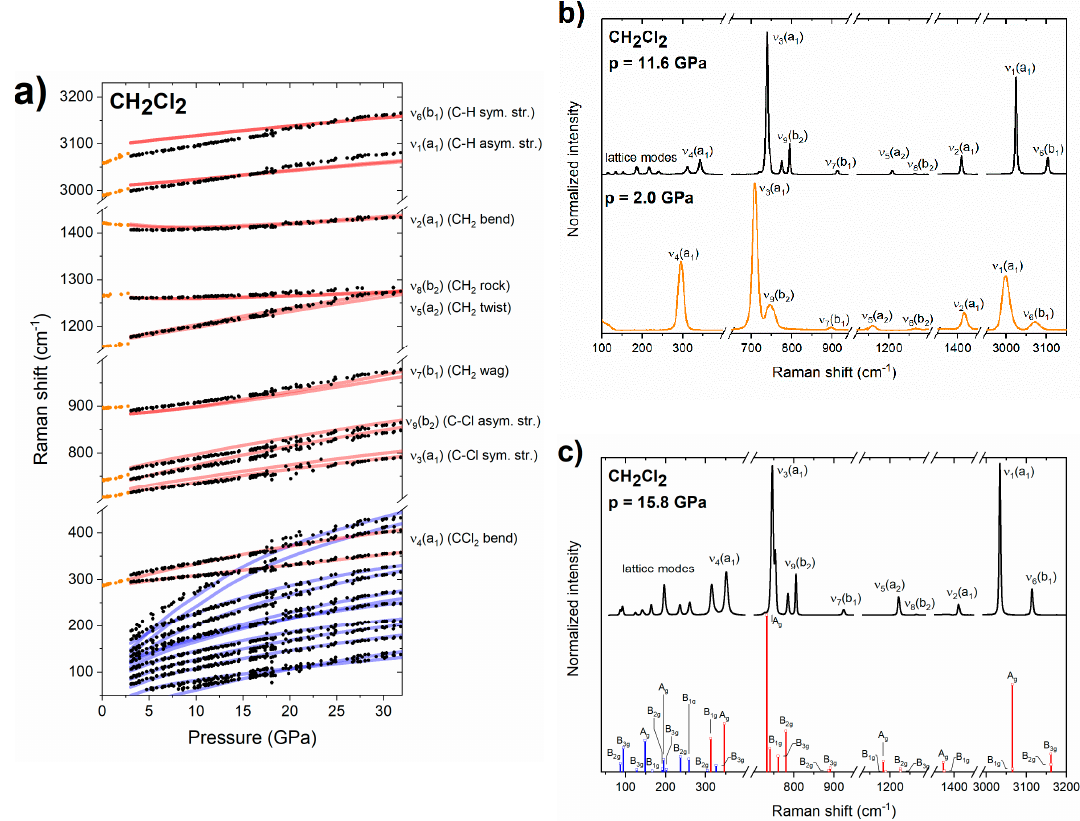
Figure 3. ( a ) Pressure dependence of the experimental frequencies of Raman bands of liquid (orange dots) and solid (black dots) for CH 2 Cl 2 . Blue / red lines mark vibrational frequencies simulated for lattice / internal Raman-active modes of the Pbcn structure. For ease of comparison the theoretical frequencies were scaled by 1.03 (with the exception of the ν 1 / ν 5 modes which were scaled by 0.99 / 1.05). ( b ) Experimental Raman spectrum of liquid / solid CH 2 Cl 2 at 0.6 / 5.4 GPa (orange / black lines). ( c ) Experimental Raman spectrum of solid CH 2 Cl 2 at 15.8 GPa together with Raman intensities simulated for the Pbcn structure (blue / red bars for lattice / internal modes, symmetry labels of vibrational modes are also given).